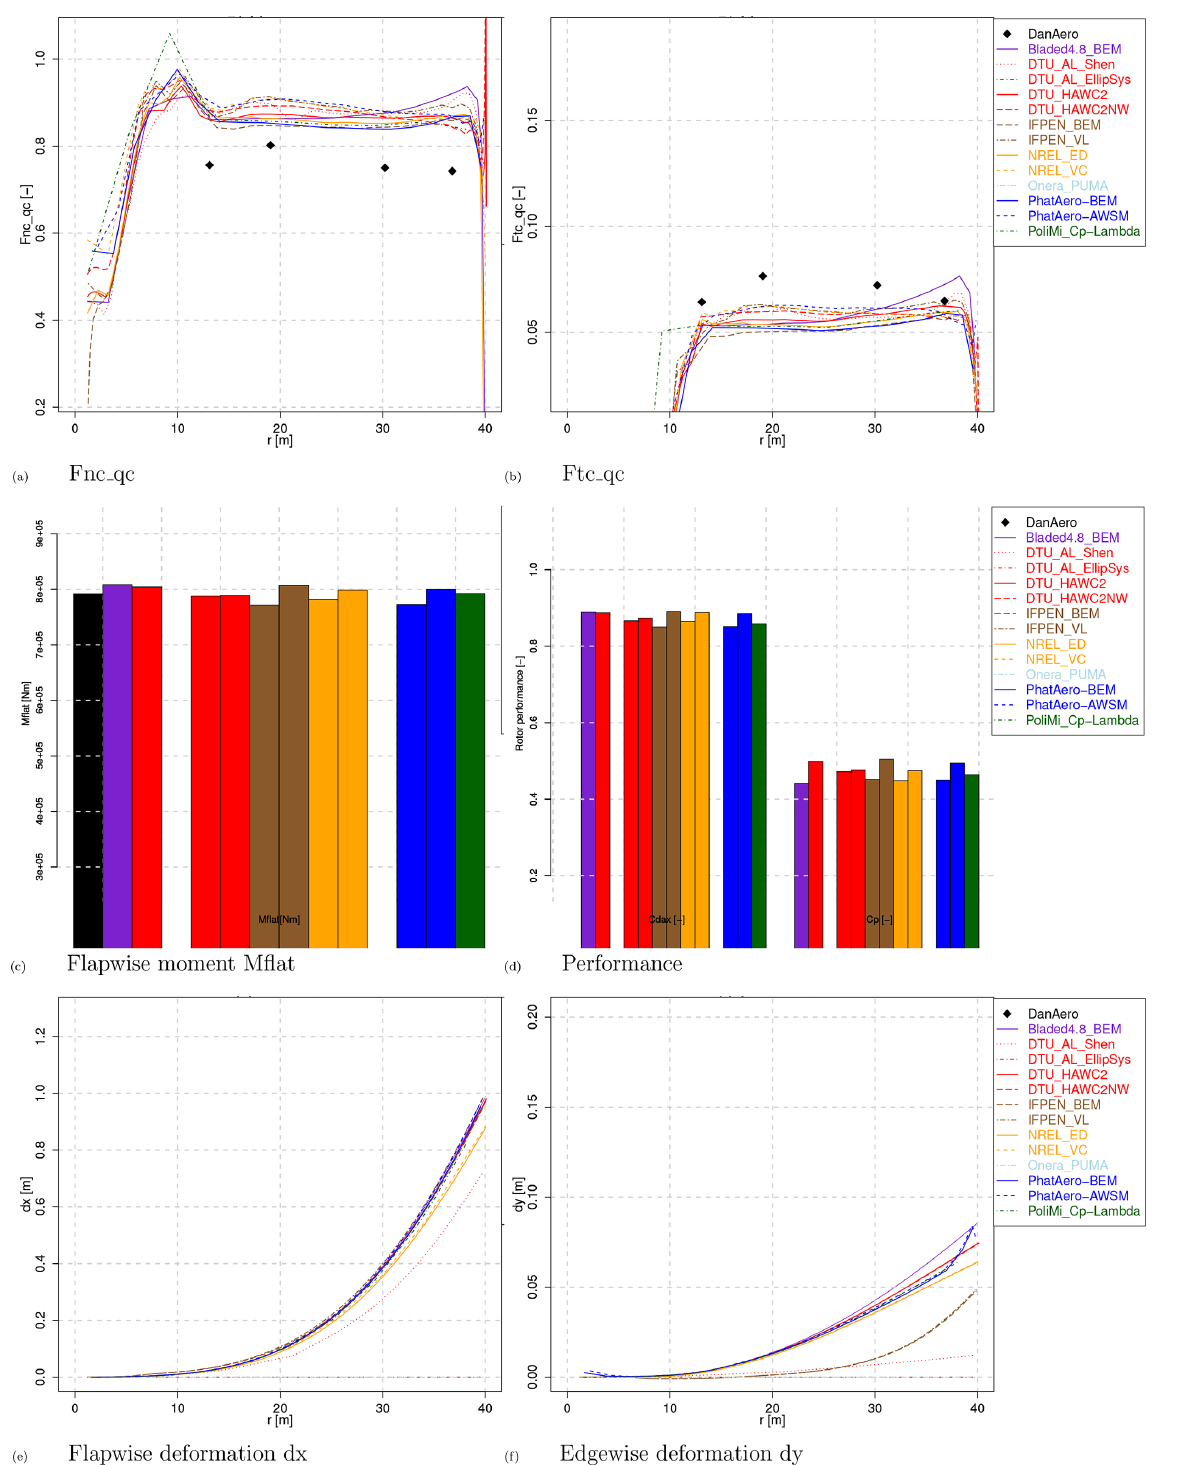
Figure 3. Loads, performance and deformations for Case IV.1.2. Note that for the bar plots the order of the bars agrees with the order of the legend